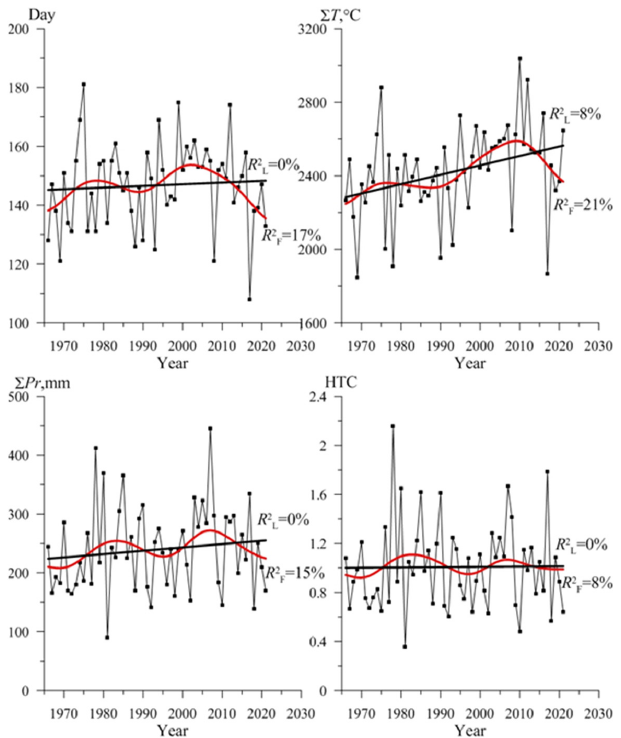
Figure 8. Long-term changes of APGS indicators (Day—the duration of the APGS, days; ∑ T —the sum of air temperatures; ∑ Pr —the sum of precipitation; HTC —Selyaninov’s Hydrothermal Coefficient) at N. Vyazovye, the Republic of Tatarstan (see Figure 2).